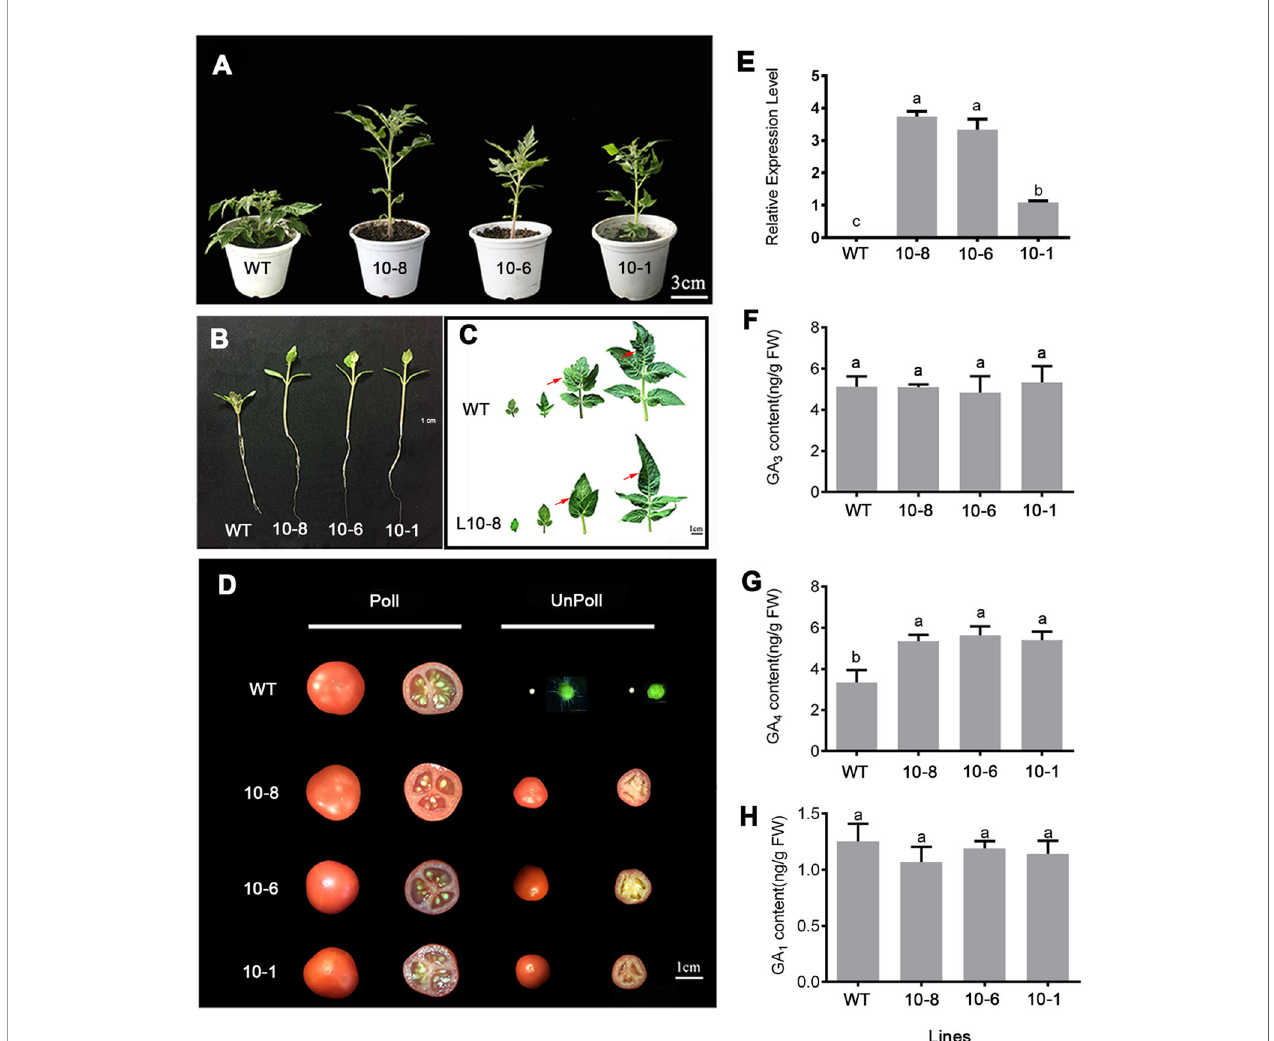
FIGURE 4 | Phenotypes of wild-type (WT) and PbGA20ox-OE lines (10-8, -6, and -1) of tomato. (A) Plant before fl owering. (B) Roots of a representative 10-day-old seeding. (C) Leaves at different positions on the plant ( fi rst to fourth, left to right). The difference points were marked with a red arrow. (D) Fruits of WT and GA20ox- OE lines. (E) Expression levels of PbGA20ox2 in young leaves of WT and transgenic lines as assessed by qRT-PCR. Line 10-1 was used as control. Ten-day-old fruits were used for phytohormone analysis. (F) GA 3 content. (G) GA 4 content. (H) GA 1 content. Data are means ± SD ( n = 3). Different letters between bars indicate signi fi cant differences at P < 0.05 (Duncan's range test). Poll, pollinated; Unpoll,